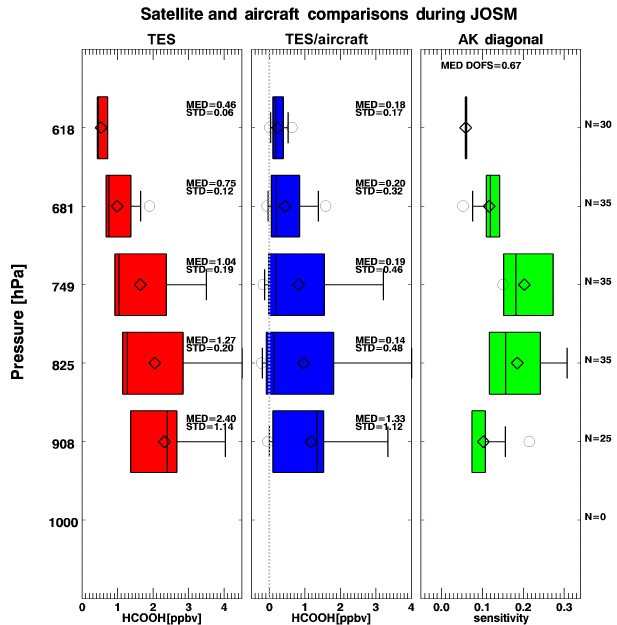
Figure 8. Summary box-and-whisker plots of the satellite and air- craft comparisons during JOSM for HCOOH, with the same plot- ting convention as Fig.